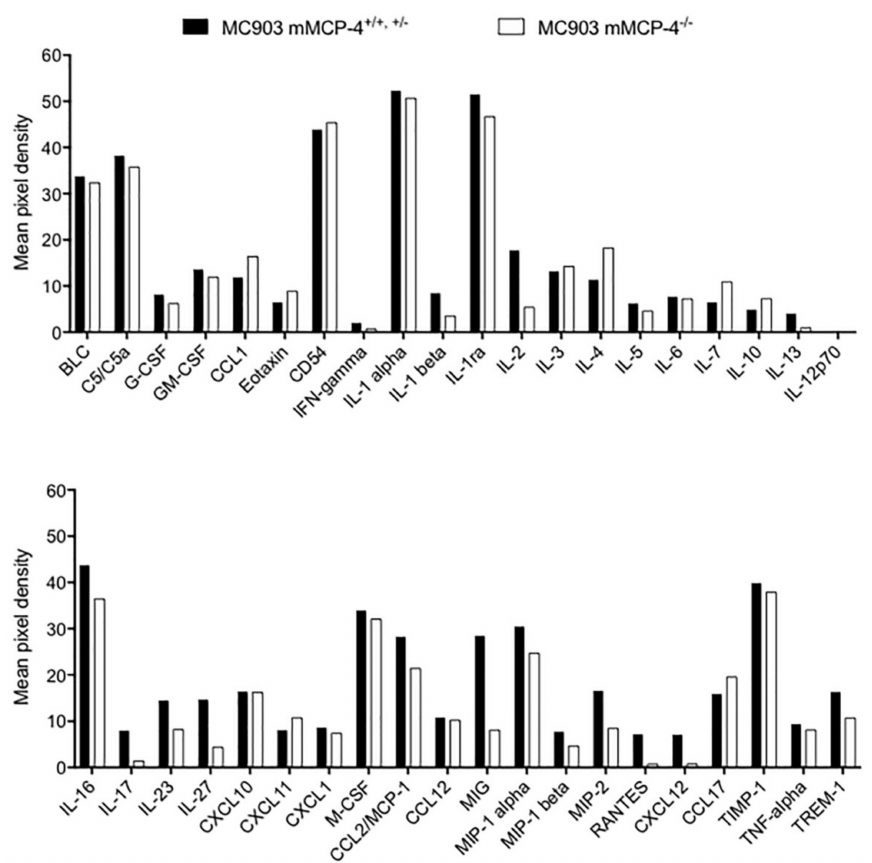
Figure 5. MC903-induced atopic dermatitis evokes the local production of inflammatory cytokines. Membrane cytokine array of ear tissue lysates from MC903-treated mMCP4 − / − and mMCP4 +/+ , +/ −